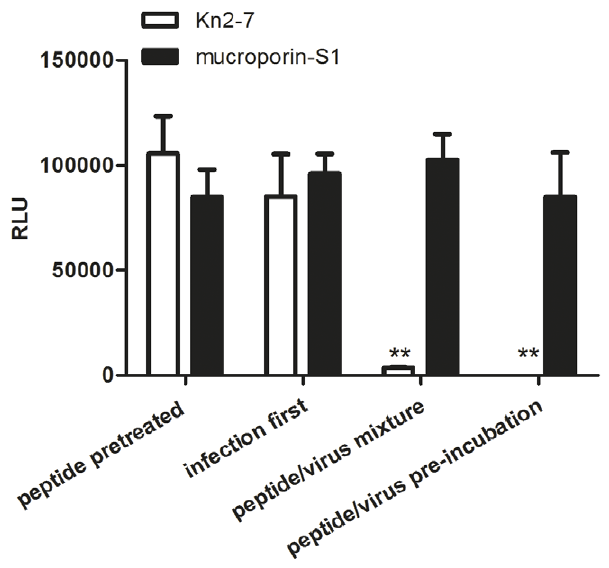
Figure 3. Directly inactivated mechanism of Kn2-7 peptide to HIV-1 PV. Four action modes of treatment between peptides with HIV- 1 PV were carried out. (1) Peptide pretreated group, TZM-bl cells were pretreated with 10 m g/ml peptide at 37 u C for 1 h and then treated with HIV-1 PV. (2) Infection first group, cells were infected with HIV-1 PV first by inoculating at 37 u C for 1 h and then treated with 10 m g/ml peptide. (3) Peptide/virus mixture group, cells were treated with mixture of HIV-1 PV and 10 m g/ml peptides immediately after mix but without inoculation. (4) Peptide/virus pre-incubation group, cells were infected with mixture of HIV-1 PV and 10 m g/ml peptides pre-incubating at 37 u C for 1 h. The inhibitory effects of different groups were determined in TZM-bl detection system. Significant reduction in the RLU value of Kn2-